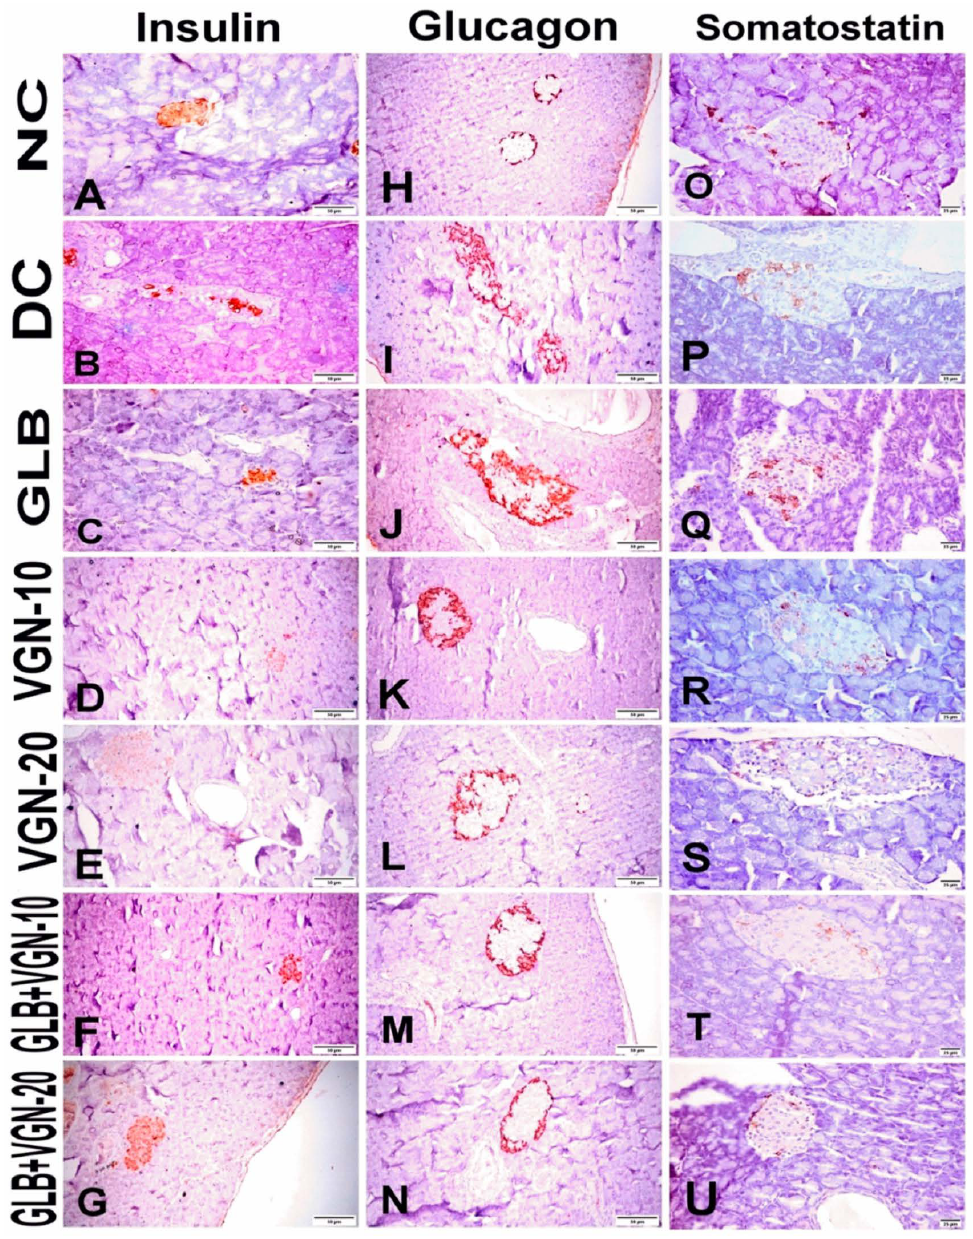
Figure 3. Representative anti-insulin, anti-glucagon and anti-somatostatin immunohistochemistry in the pancreases of all experimental groups: ( A – G ) anti-insulin protein expression; ( H – N ) anti-glucagon protein expression; ( O – U ) anti-somatostatin protein expression; ( A , H , O ) NC group; ( B , I , P ) DC group; ( C , J , Q ) GLB group; ( D , K , R ) VGN-10 group; ( E , L , S ) VGN-20 group; ( F , M , T ) GLB+VGN-10 group; ( G , N , U ) GLB+VGN-20